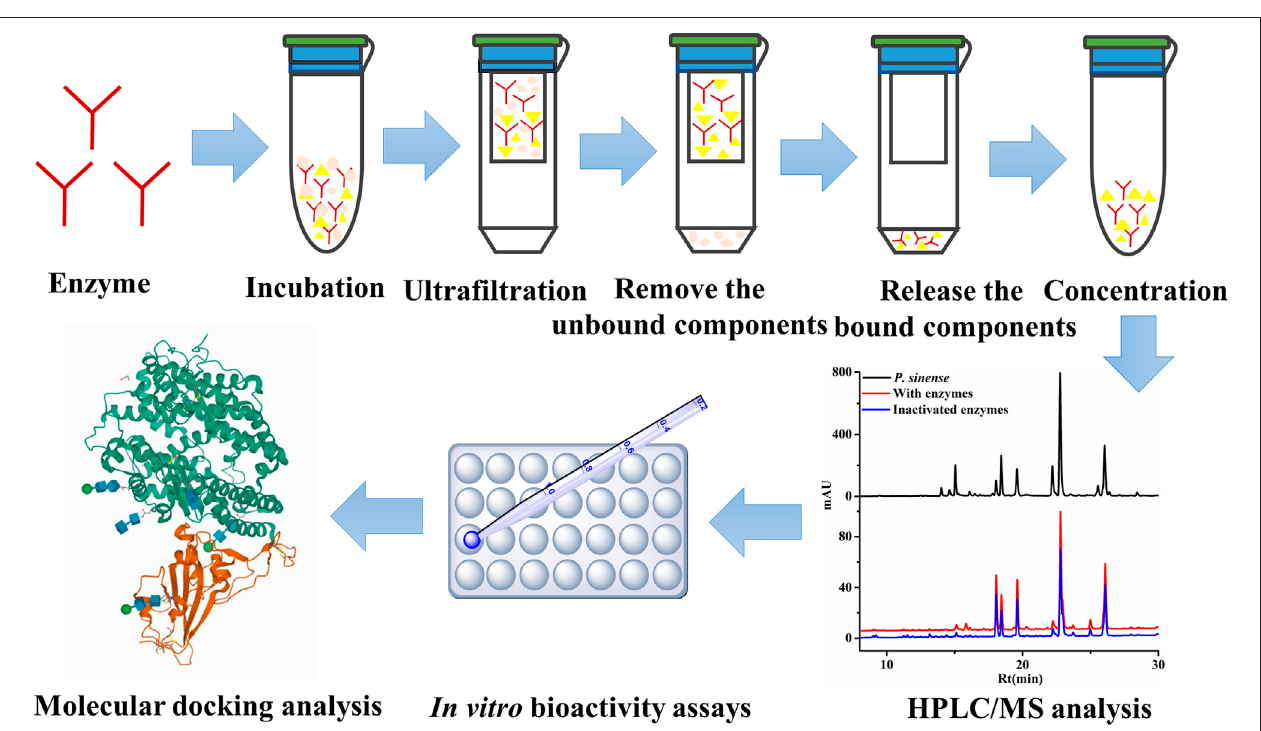
FIGURE 6 | Schematic diagram of UF – HPLC/MS assay to screen and identify the ligands against different drug targets.